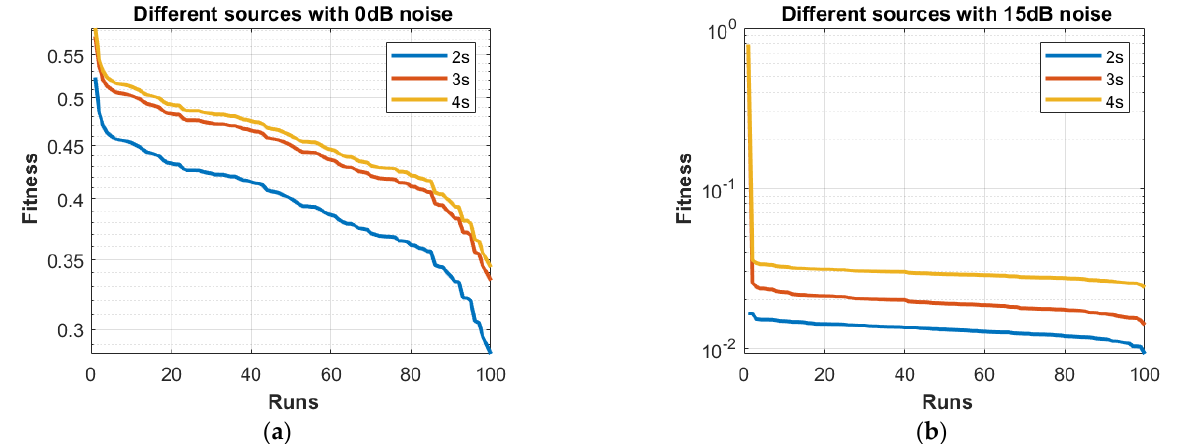
Figure 4. Fitness with Noises ( a ) 0 dB and ( b )15 dB.